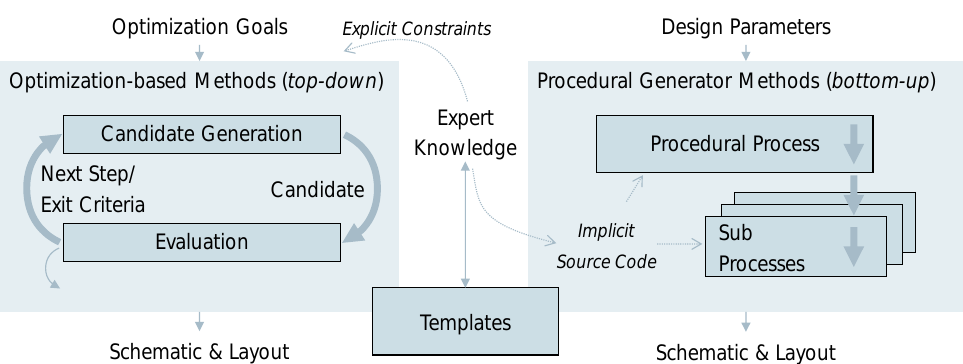
Figure 2. Comparison of top-down optimization ( left ) and bottom-up procedural generation ( right ). While optimization-based approaches search a solution that fulfills the given set of constraints and that improves the performance, procedural approaches execute a pre-defined design strategy in form of generator source code that is based on expert knowledge. This figure is adapted from both [5,6] to which we added templates as our proposal to link both methods with each